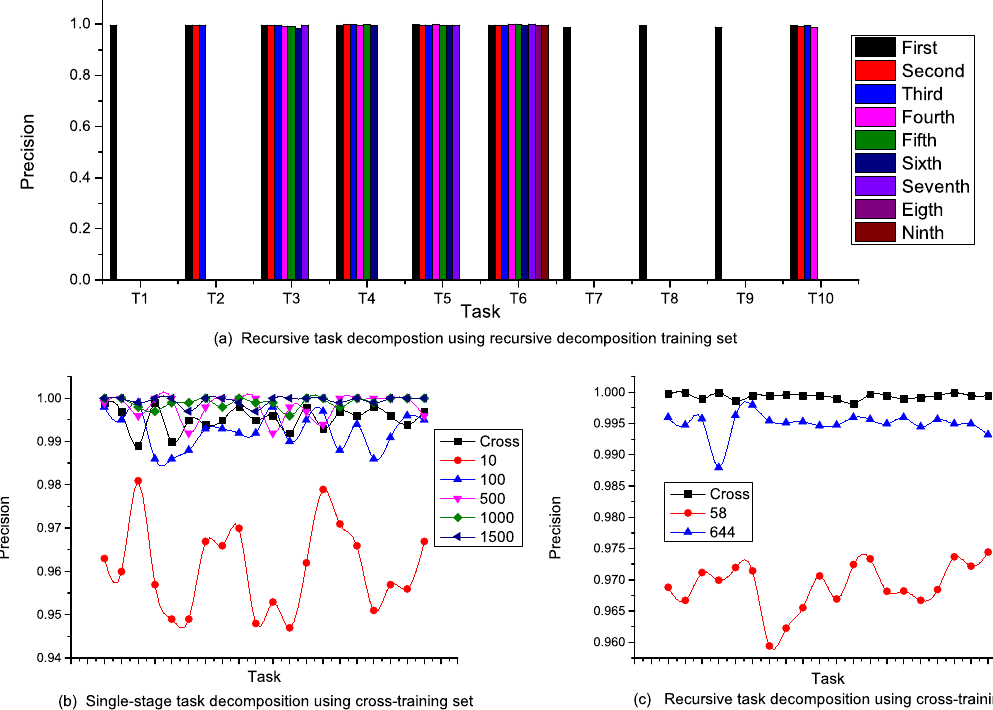
Figure 9. Recursive decomposition and cross-validation of single-stage decomposition and recursive